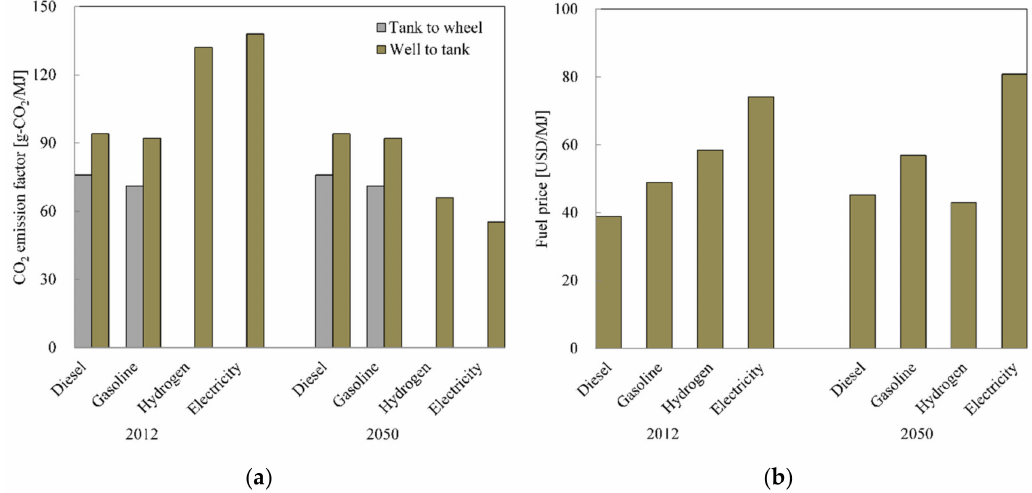
Figure 8. Fuel information: ( a ) Tank to wheel and well to wheel CO 2 emission factors; ( b )